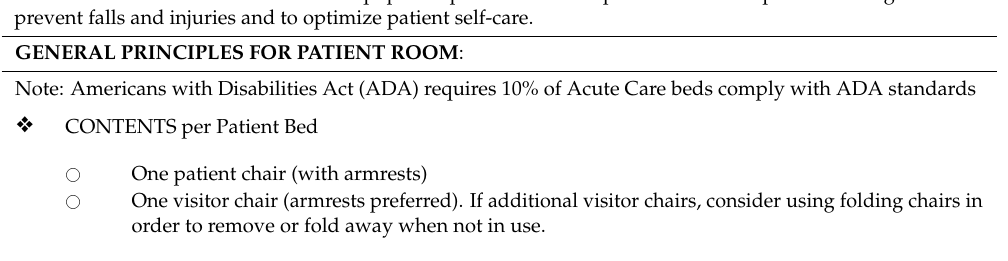
Table 1. Prepared and Safe Hospital